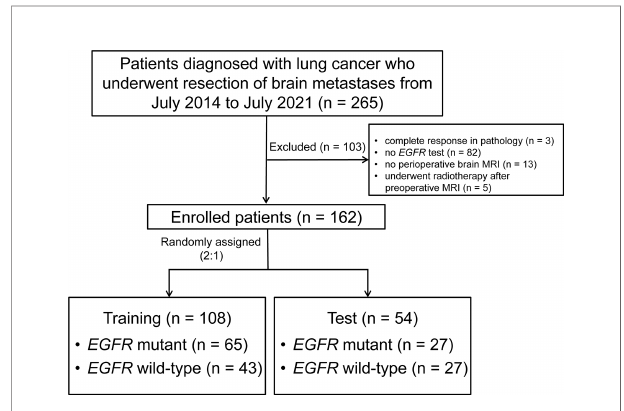
FIGURE 1 | The participant recruitment process MRI, magnetic resonance imaging; EGFR , epidermal growth factor